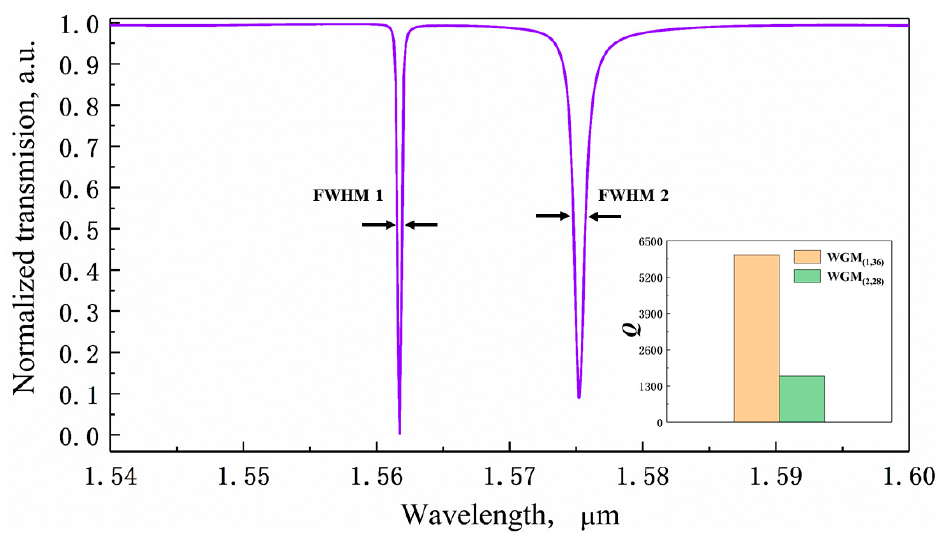
Figure 4. The transmission spectrum of MDR near the 1.55 μ m wavelength band using FDTD simulation. The inset shows the comparison of the Q factor of two WGMs.